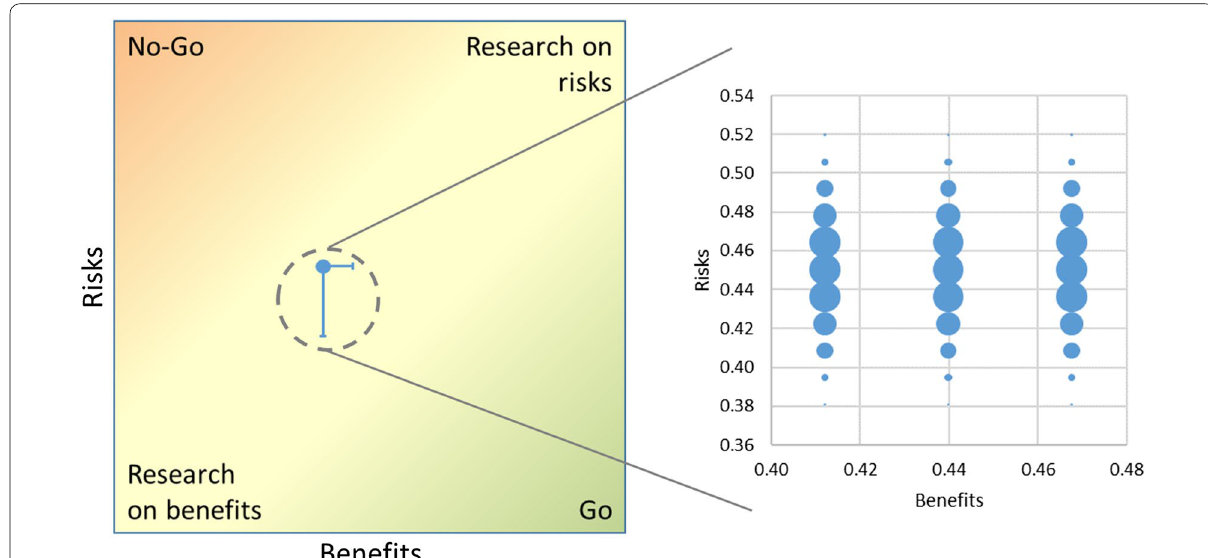
Fig. 1 Initial data (from LnS) and uncertainties. On the left, the original LnS result space is presented. The result is depicted as a blue dot with uncertainty bars, the results domain is subdivided into four areas: “No-Go”, “Research on risks”, “Go” and “Research on benefits”. On the right side, the result area is zoomed in and a bubble chart is presented which depicts all possible results due to uncertainty. The area of each bubble represents its point’s probability. The three vertical “stripes” which are clearly visible in the right side are due to the fact that there is only one benefits’ unknown which has three possible different states while the higher number of points along each stripe derives from the integration of the four